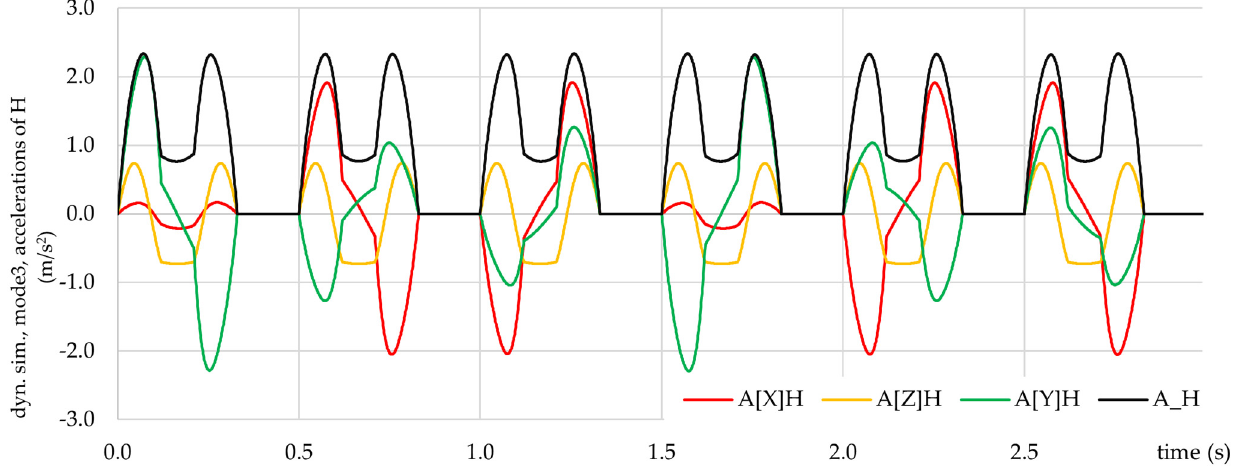
Figure 5. Computed results in Mode 1 in terms of accelerations of H.